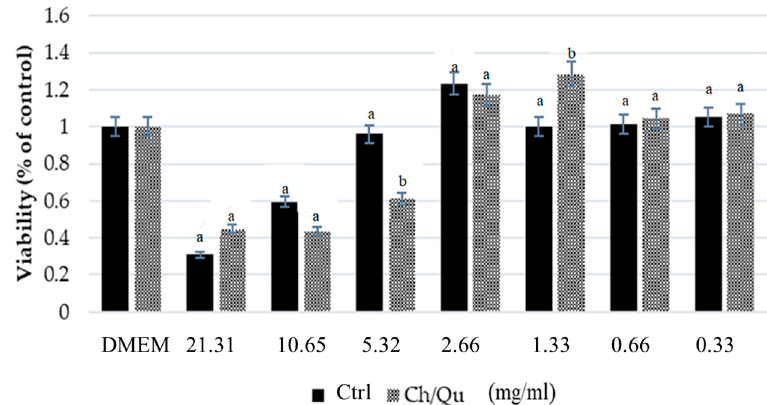
Figure 1. Effect of different concentrations (21.31–0.33 mg/mL) of Ctrl and Ch/Qu digesta (<3 kDa) on intestinal porcine epithelial cell line IPEC-J2 cell viability (via 3-(4,5-dimethylthiazol-2-yl)-2,5 diphenyltetrazolium bromide MTT assay). Data are expressed as percentage of control (DMEM - Dulbecco’s Modified Eagle Medium + Ham’s F-12 mixture, 0 mg/mL) as least squares means (LSMEANS) and standard errors of the means (SEM) ( n = 3). At each concentration, different letters (a,b) denote statistical differences between Ch/Qu and Ctrl.